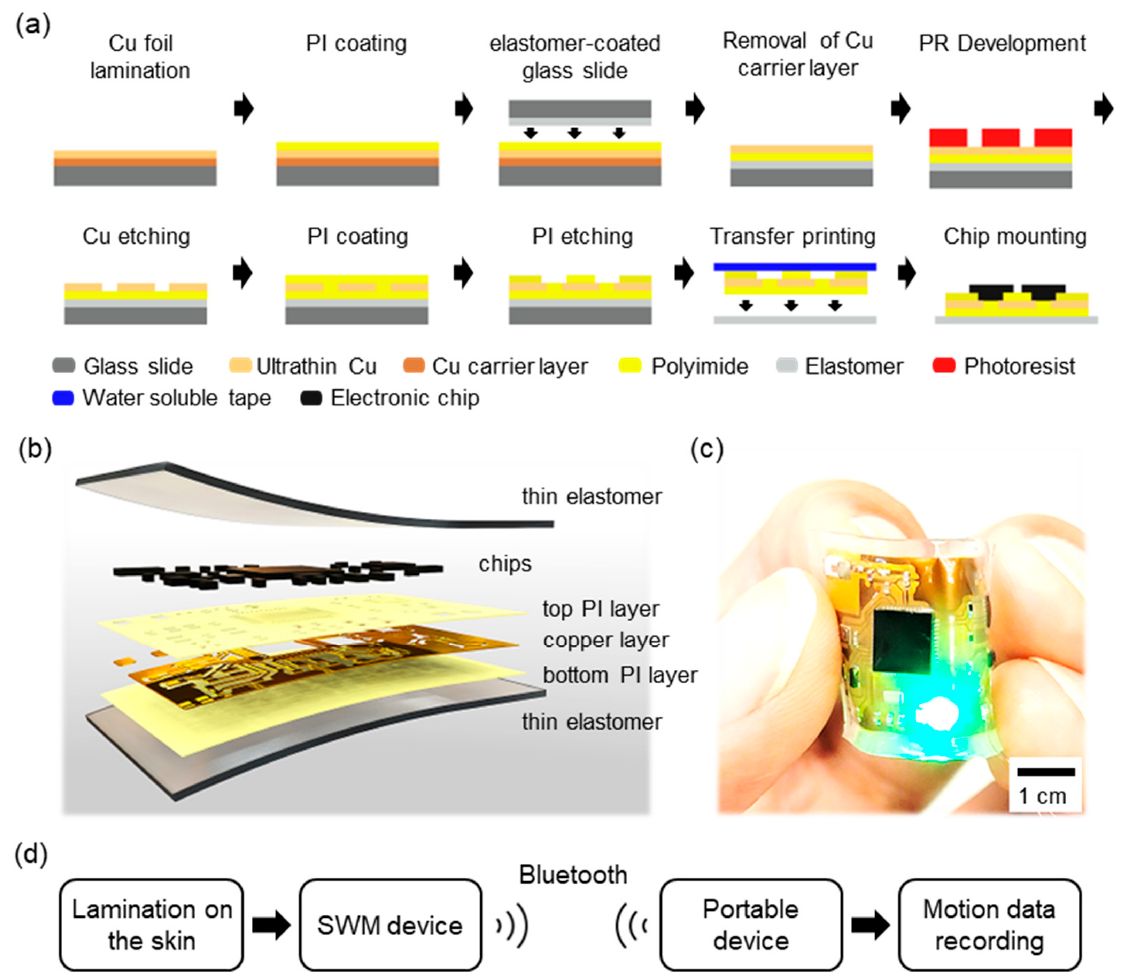
Figure 1. The overview of the skin-wearable device. ( a ) Illustration of device fabrication process using an ultrathin Cu film. ( b ) Exploded view of the device showing materials for each layer. ( c ) Device bending. ( d ) The flow of motion data from the skin to analysis.